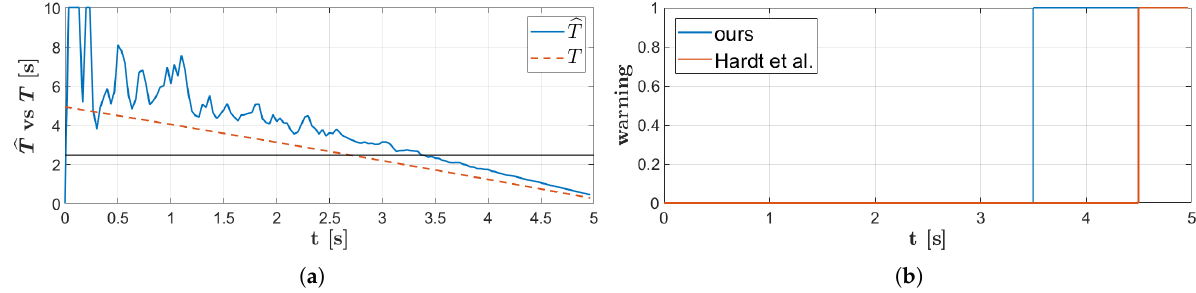
Figure 3. Simulation results, through MIL testing, in the CCRS scenario. ( a ) Time-history of the estimated time-to-collision, (cid:98) T , and of the real one, T . The warning threshold is shown as a constant horizontal line; ( b ) time-history of the forward collision warning activation.